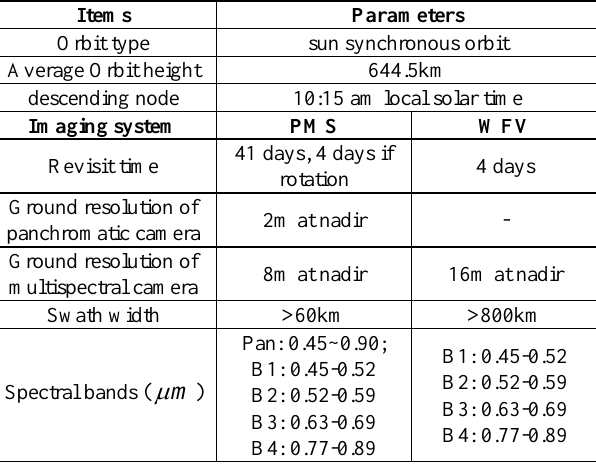
Table 1. Part of the parameters of GF-1 satellite and its imaging systems